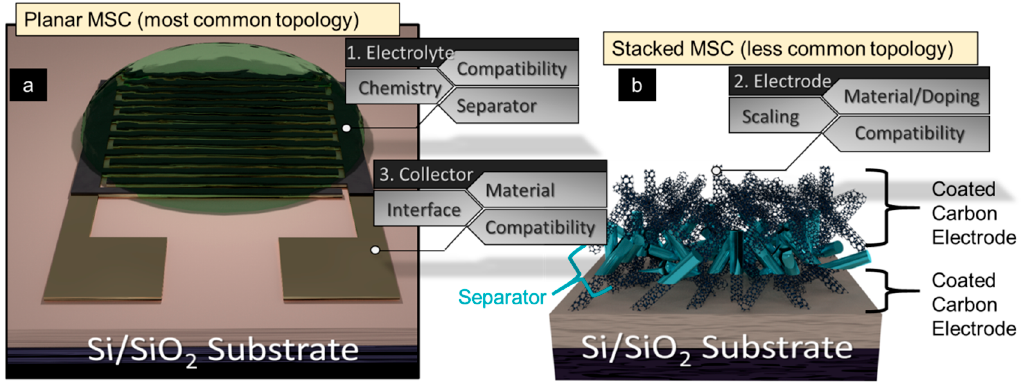
Figure 1. Schematic of a microsupercapacitors (MSCs)—planar ( a ) and stacked ( b )—and its design parameters. There are 3 primary areas for performance improvement—electrolyte, electrode, and current collector. Each of these areas have 3 subset groups for improvement. This work aims to provide an overview of each area and subset group.